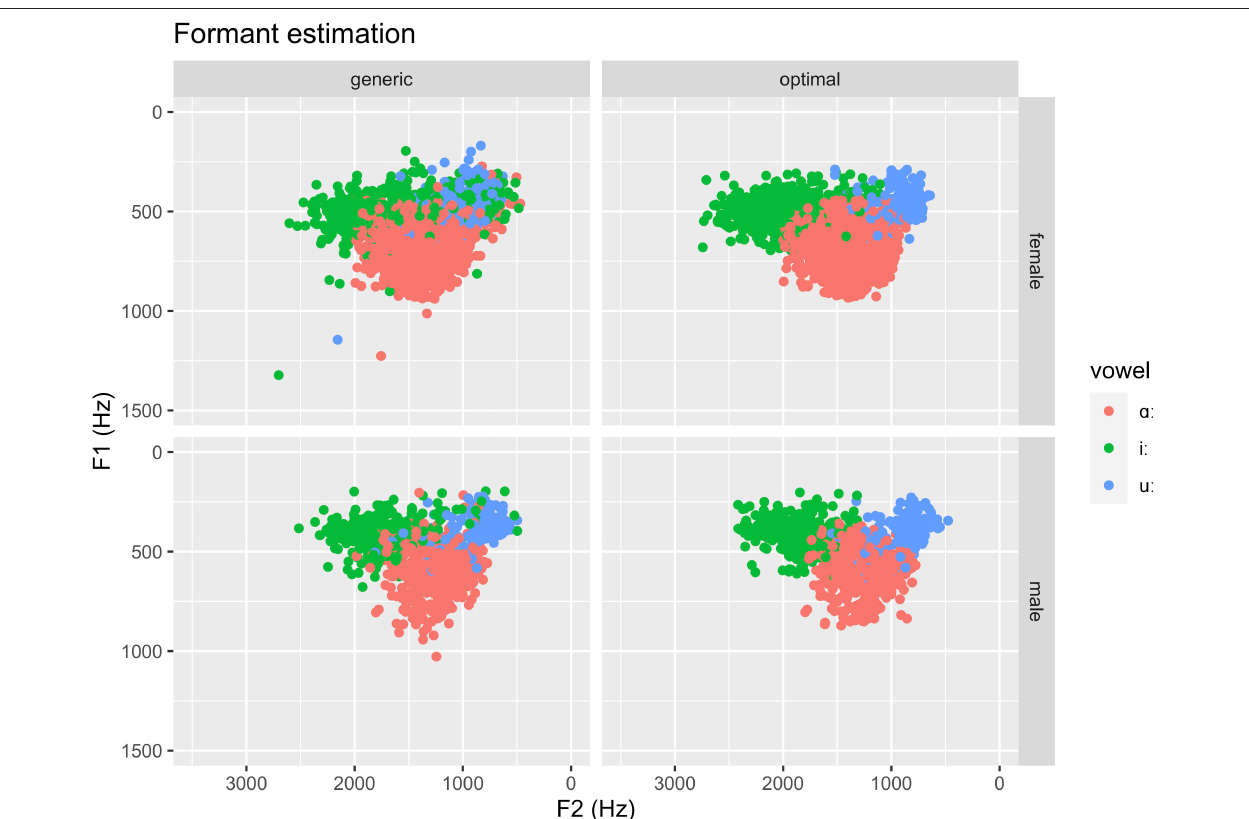
FIGURE 4 | Illustration of formant estimations. Top: female speakers. Bottom: male speakers. Left: generic formant ceiling. Right: optimal formant ceiling. Note that outliers (in terms of either F 1 , F 2 or both, estimated using optimal formant ceiling settings) are not included in the illustration.